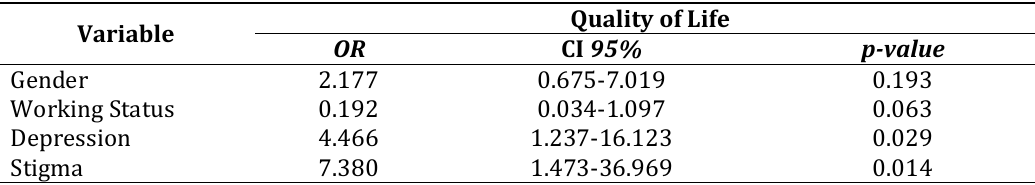
Model of multivariate analysis between quality of life (independent variable) and cofounding variable (gender, working status) and dependent variable (depression, stigma)